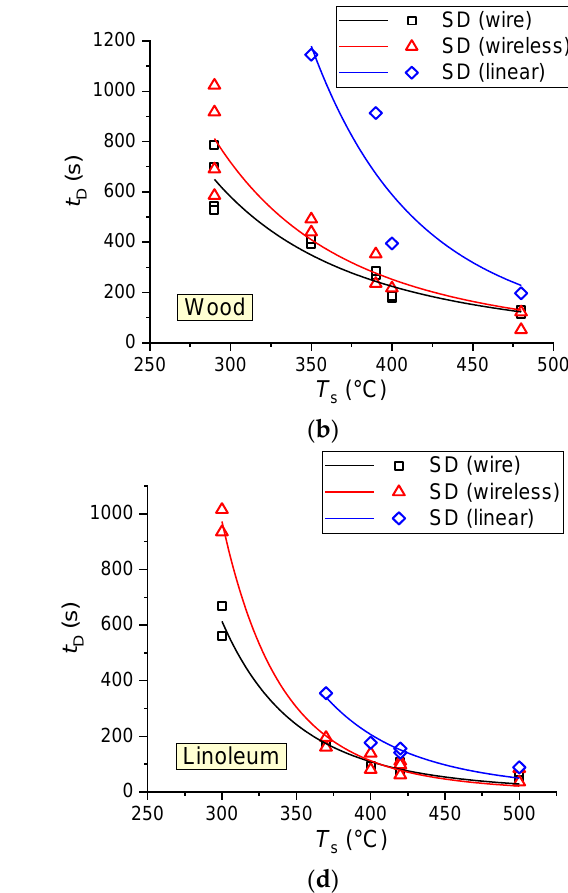
Figure 7. Activation delay times of wireless SD, when varying the sample mass in the experiments with open flame: ( a ) wood; ( b ) paper; ( c ) cardboard. Figures 8 and 9 present the curves of the SD activation delay times versus the hot plate surface temperature and model fire surface area, when simulating unsafe operation of heating equipment (hot plate).